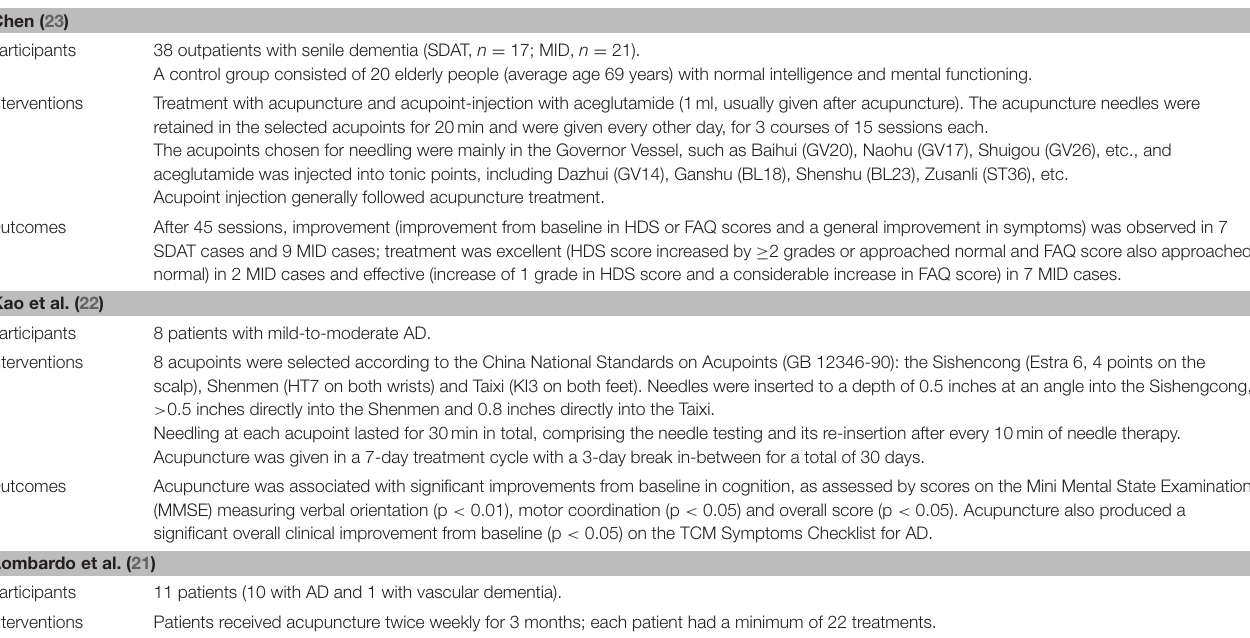
TABLE 3 | Overview of characteristics of included studies evaluating acupuncture for Alzheimer’s disease. Chen (23)